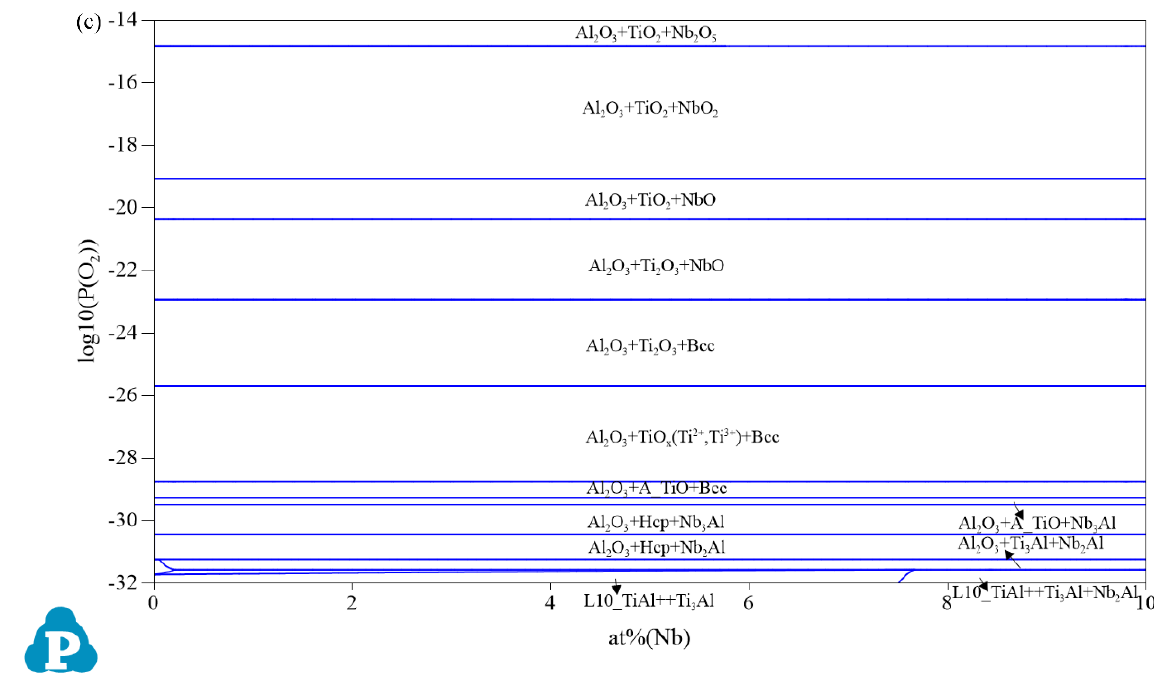
Figure 2. Initial oxidation products of Ti-45Al-xNb alloy at 700 °C ( a ), 800 °C ( b ), and 900 °C ( c ).